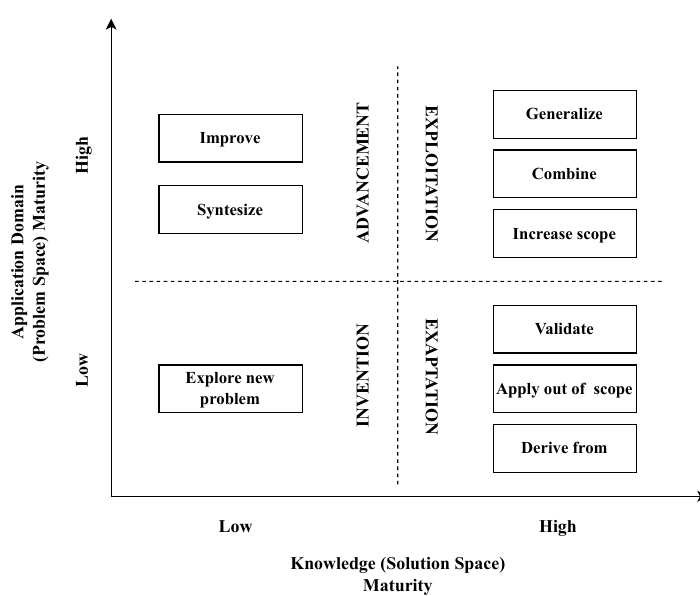
Figure 4. The Integrated Innovation Strategies Framework [19].